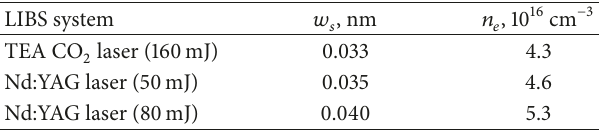
Table 3: Electron number density calculated from Stark width of Al I 396.15 nm line.